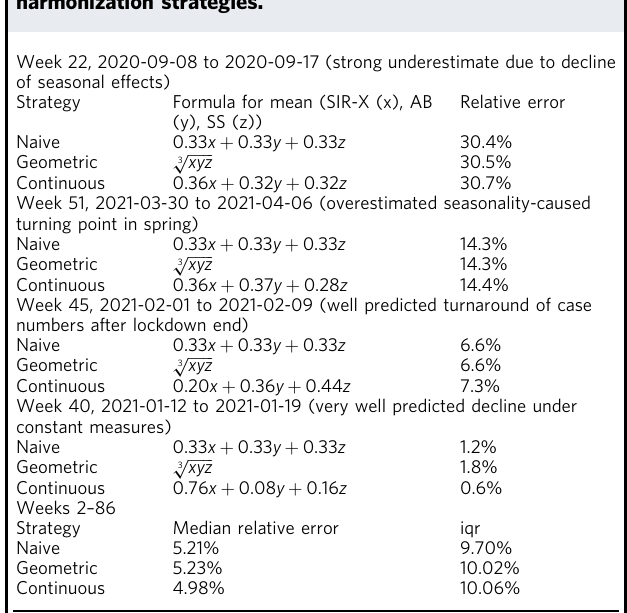
Table 1 Forecast accuracy with different model harmonization